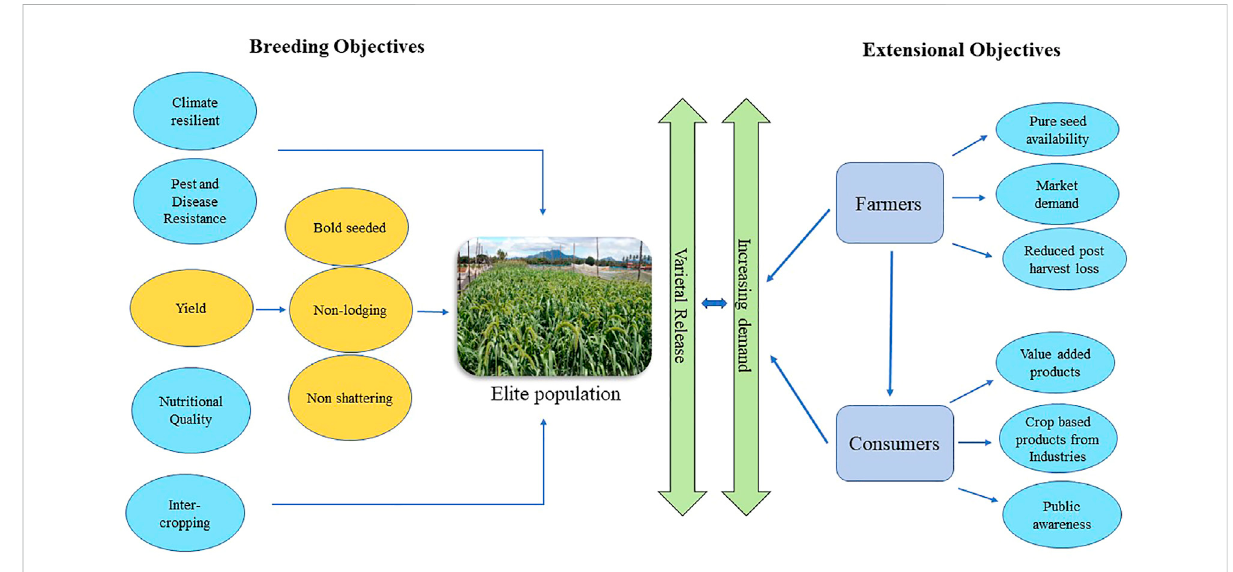
FIGURE 4 Road map for revitalizing small